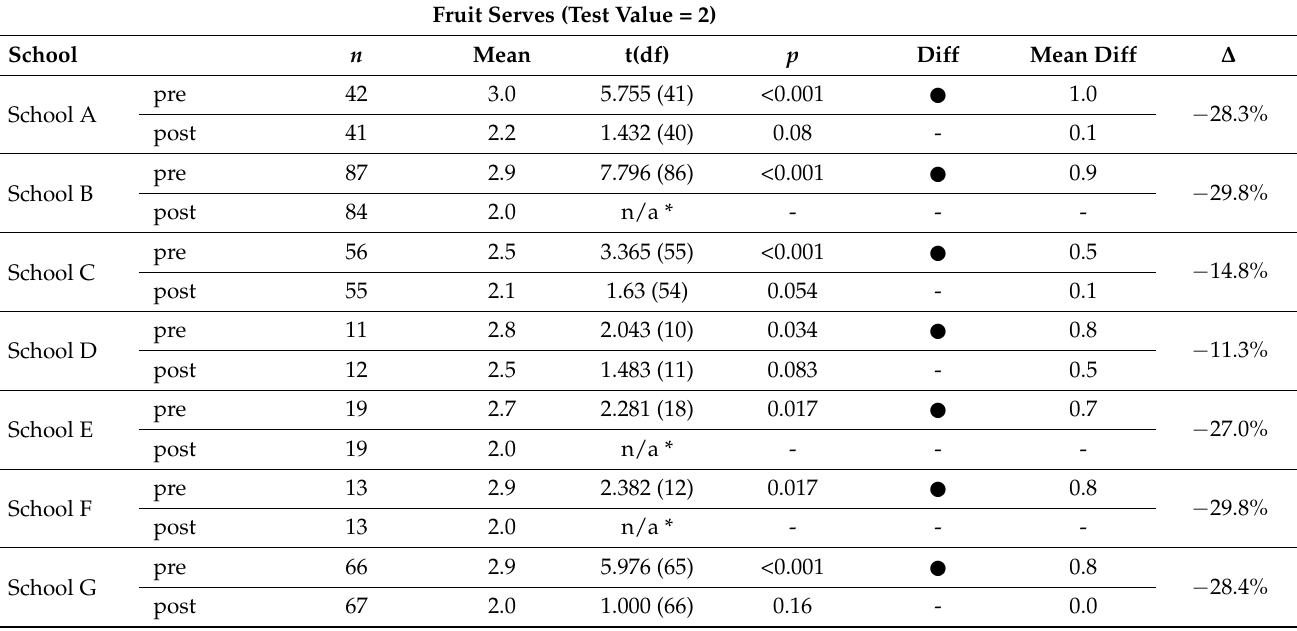
Table 4. One Sample t-Test results fruit—Nutrition Module. Fruit Serves (Test Value =